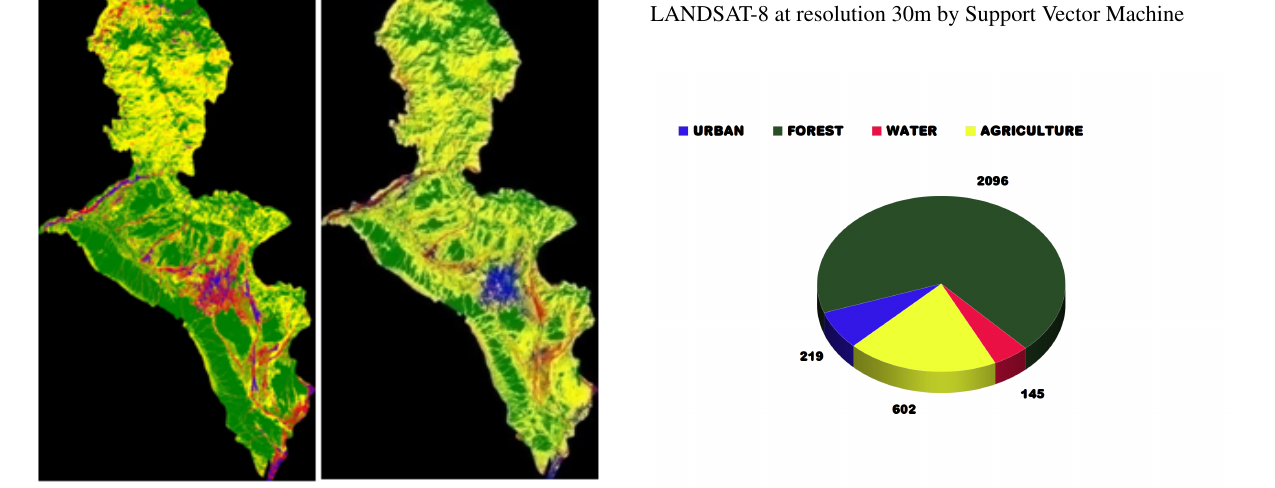
Figure 10: Accuracy generated by classification algorithms over